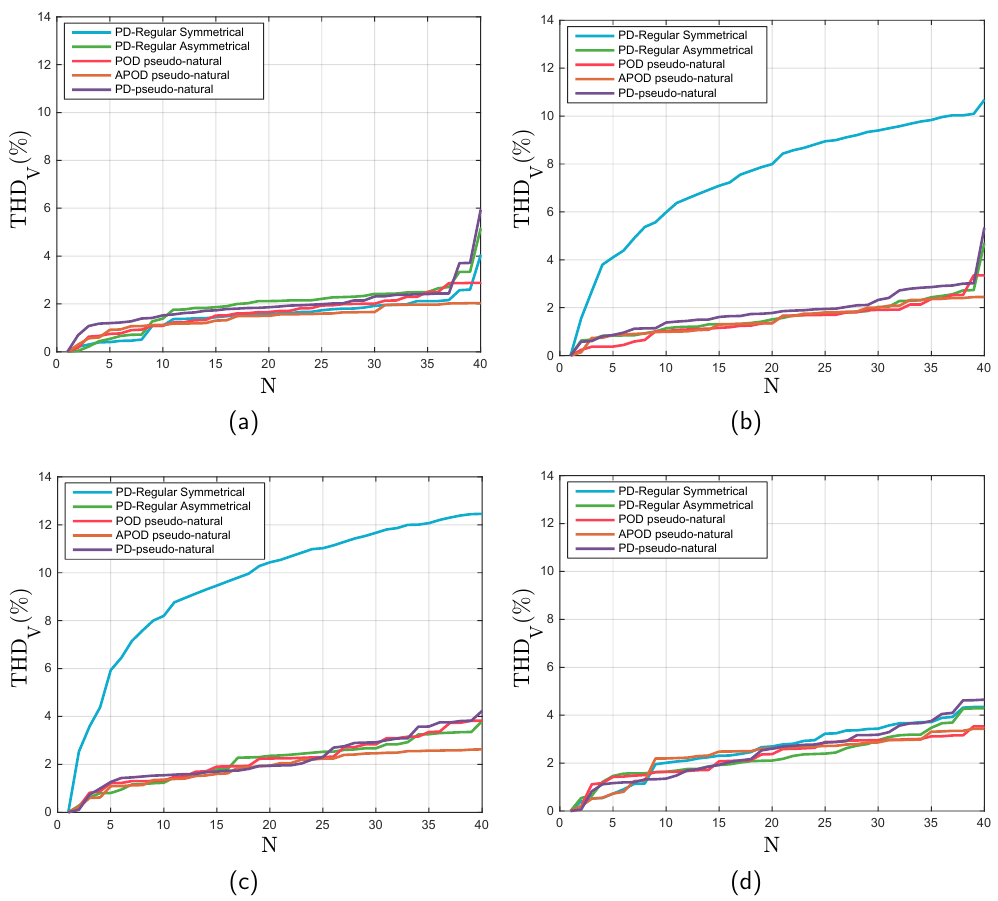
Figure 8. THD V of PD, POD, and APOD with pseudo-natural sampling and of PD with regular symmetrical and asymmetrical sampling with level distribution K = 0.5, r 1 = r 2 = r 3 = r 4 = 0.5, and modulation index Ma: ( a ) 0.9, ( b ) 0.8, ( c ) 0.7, and ( d )